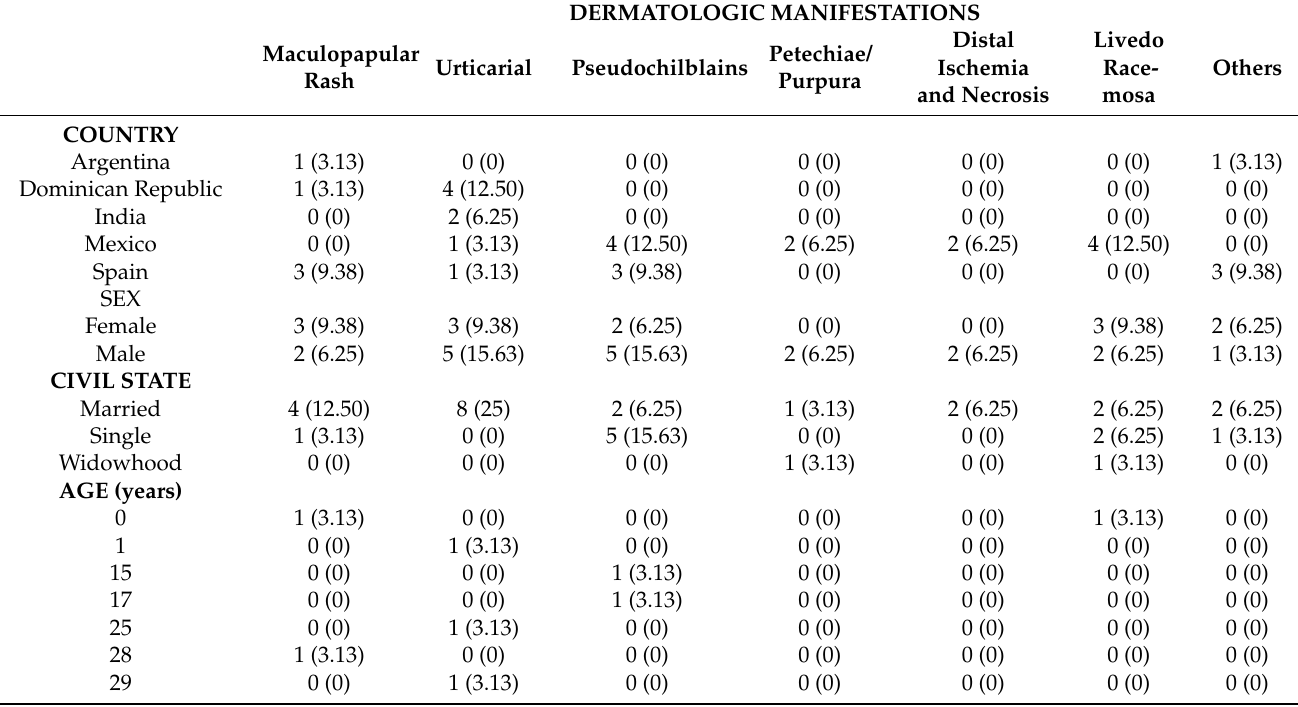
Table 1. Sociodemographic and clinical characteristics of skin lesions in COVID-19